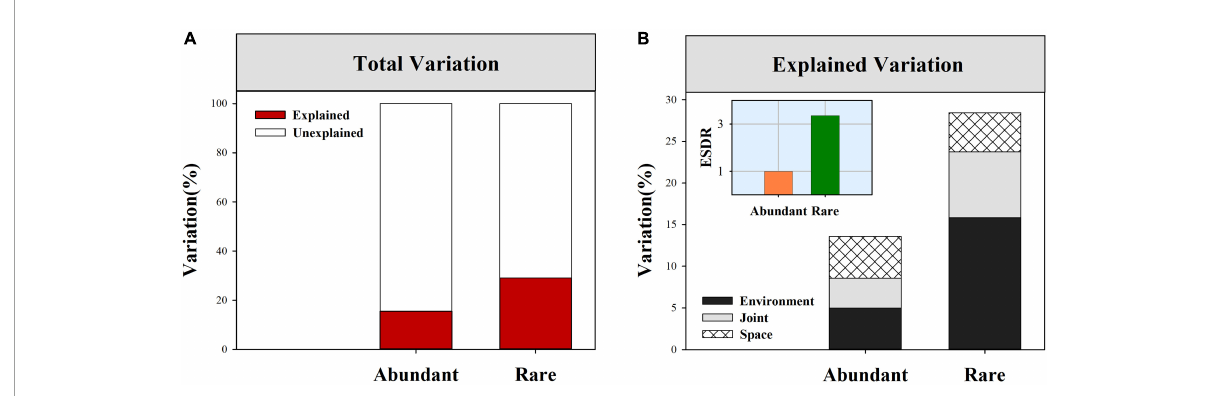
FIGURE4 Percent of β -deviations for abundant and rare fungal subcommunities explained by spatial and environmental variables. (A) Total variation in β -deviations were explained by full model. (B) Variation in β -deviations were explained by spatial and environmental variables after forward-model selection.